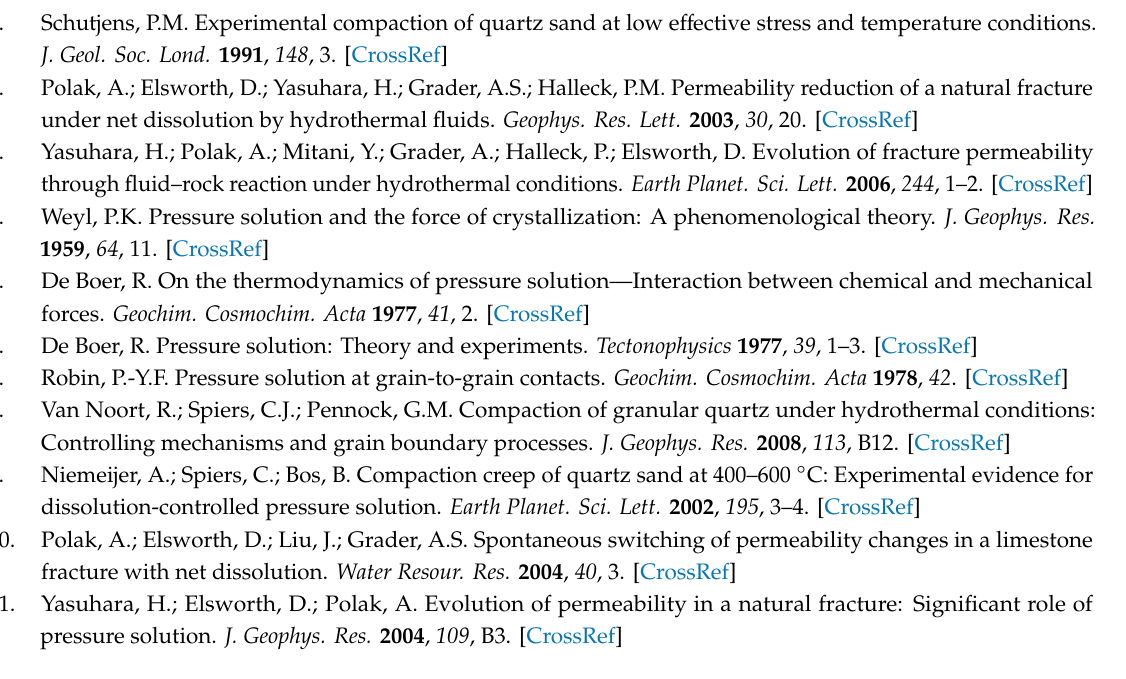
Table S1. Hydraulic aperture, Table S2. Mechanical aperture, Table S3. Fluid